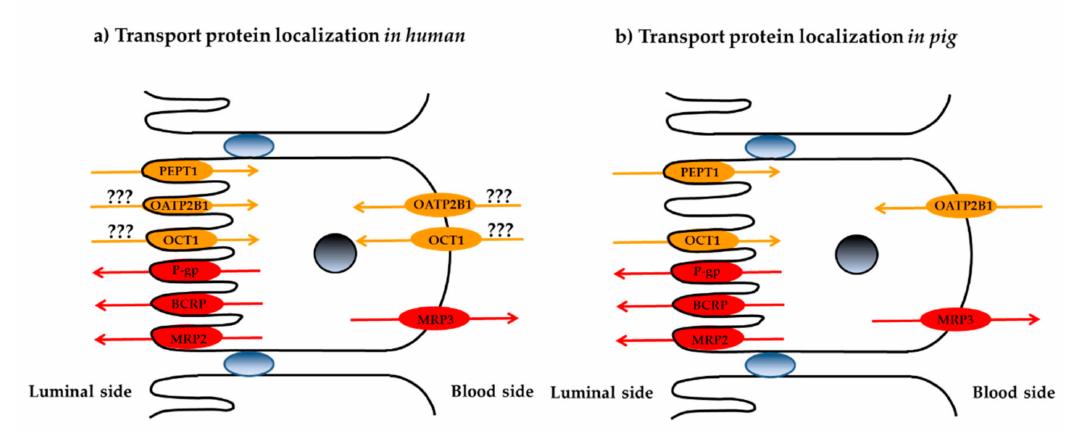
Figure 5. Comparison of the putative apical/basolateral localizations of membrane transporters in ( a ) human intestine and ( b ) porcine intestine. Uptake transporters are indicated in orange, efflux transporters are in red.